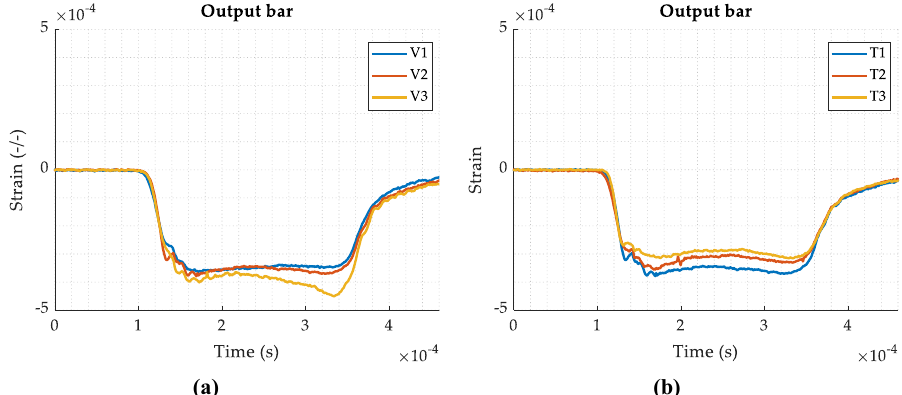
Fig 4. Deformation curves measured in the output bar: (a) at constant temperature (293 K) for 3 impact speeds (V1 = 6 m/s, V2 = 11 m/s and V3 = 13.2 m/s), (b) at constant impact speed (11 m/s) for 3 temperatures (T1 = 293 K, T2 = 373 K and T3 = 473